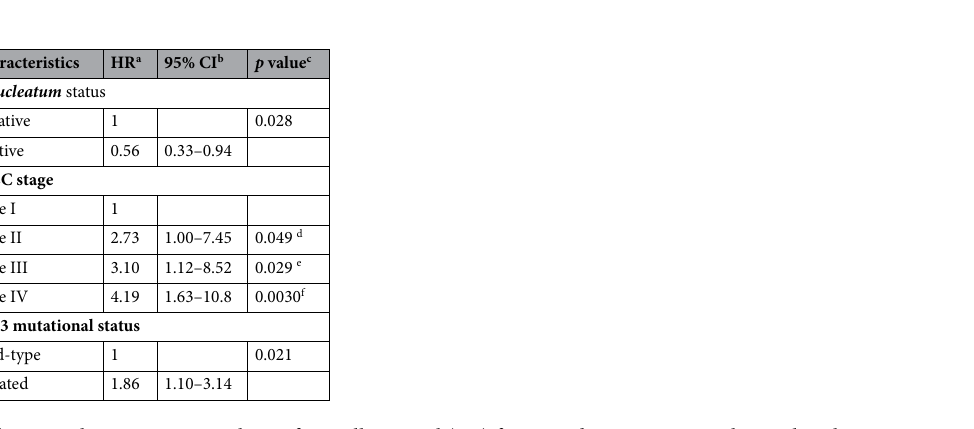
Table 3. Multivariate Cox analysis of overall survival (OS) for F. nucleatum status in the total oral cavity population of 151 patients of the merged cohort. a Hazard ratio. b 95% Confidential interval. c Multivariate cox analysis. d Stages I versus II. e Stages I versus III. f Stages I versus